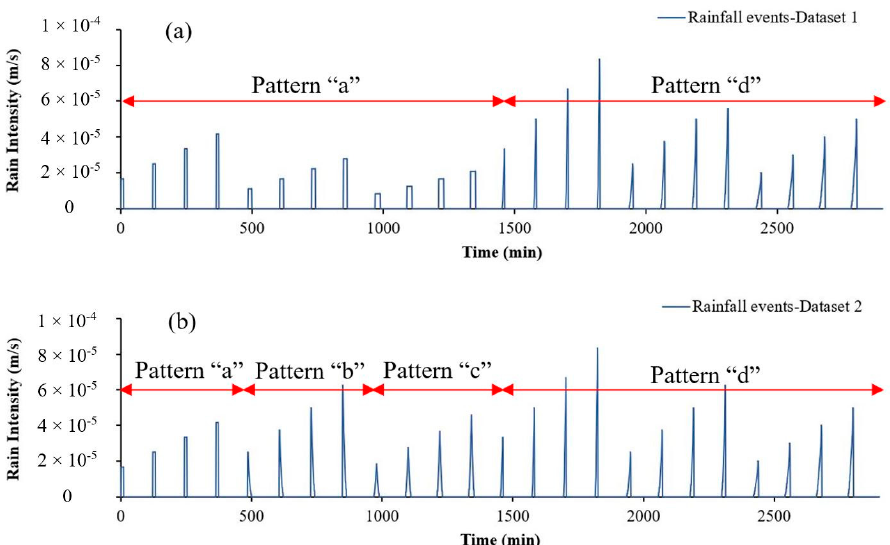
Figure 14. Two rainfall datasets with the different number of patterns ( a ) dataset 1 consists of rainfall events with pattern types of “a” and “d” and ( b ) dataset 2 consists of rainfall events with pattern types of “a”, “b”, “c”, and “d”.